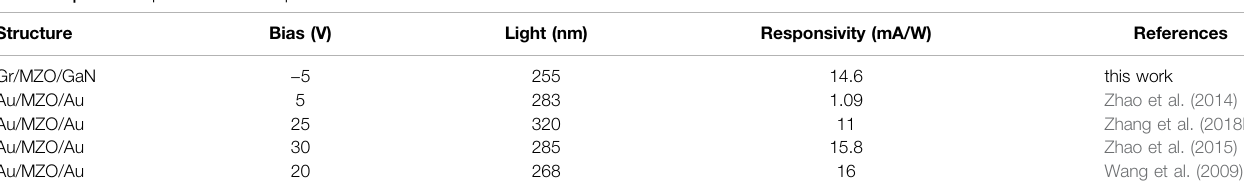
TABLE 1 | Detector performance